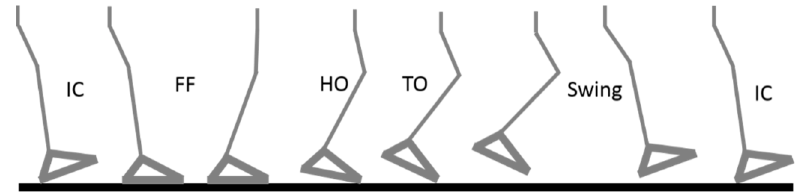
Figure 1. Walking gait classification. Initial Contact (IC), Foot Flat (FF), Heel-Off (HO), Toe-Off